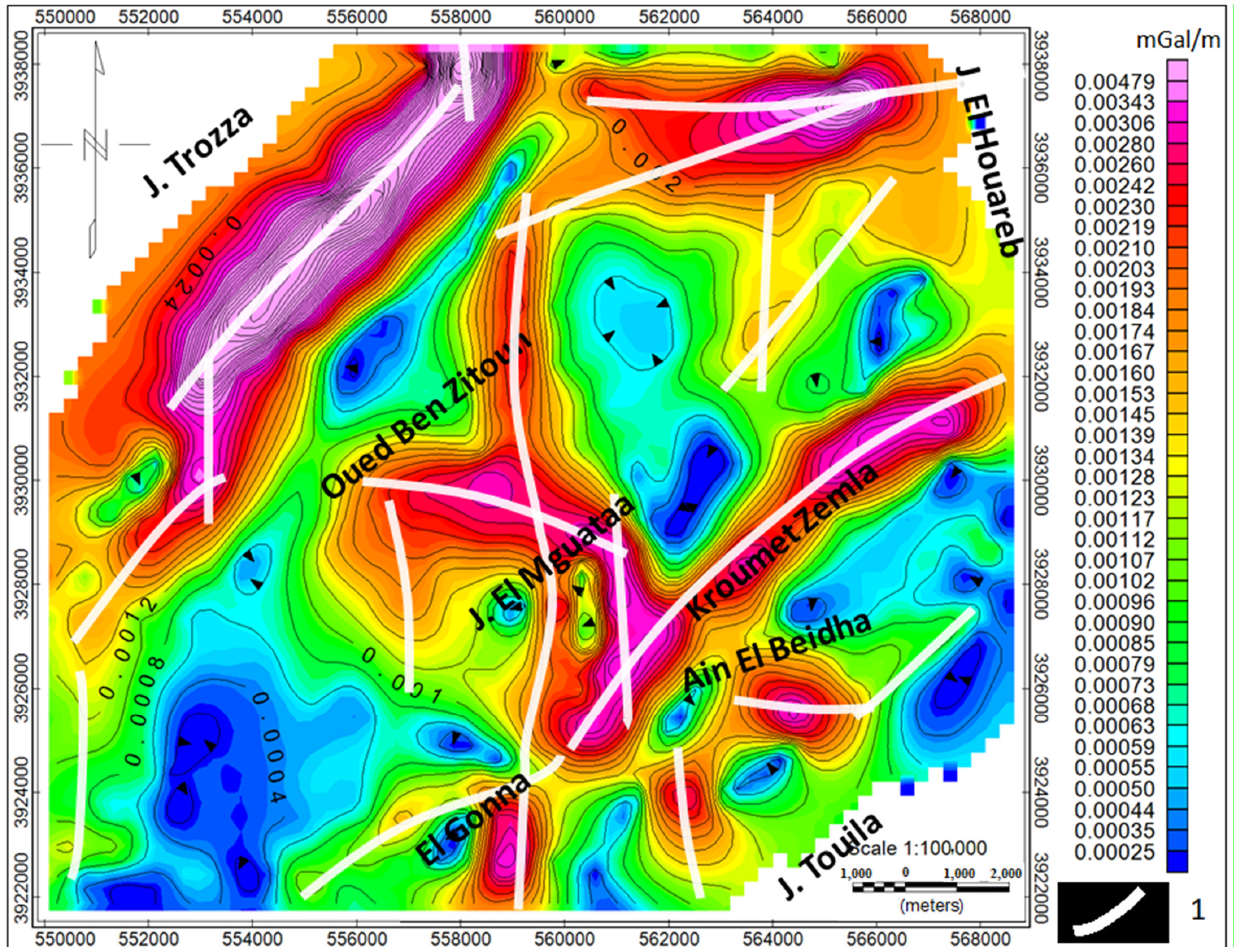
Figure 7. Interpreted magnitude of horizontal gravity gradient map of the Ain El Beidha plain. (1) Lineaments